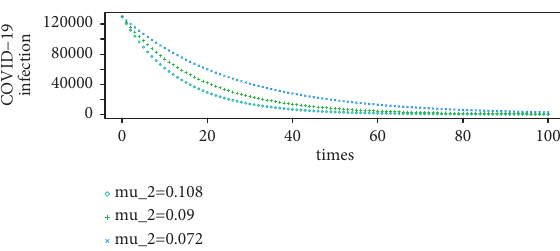
Figure 7: Simulation of COVID-19 infection at different rates ( μ inward shift in the COVID-19 infection curve towards the